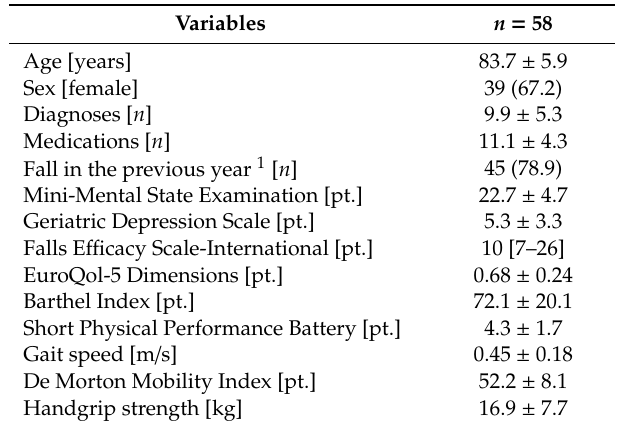
Table 1. Participant